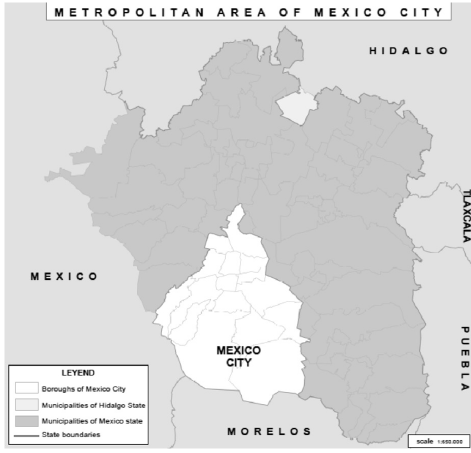
Figure 3: Mexico City Metropolitan